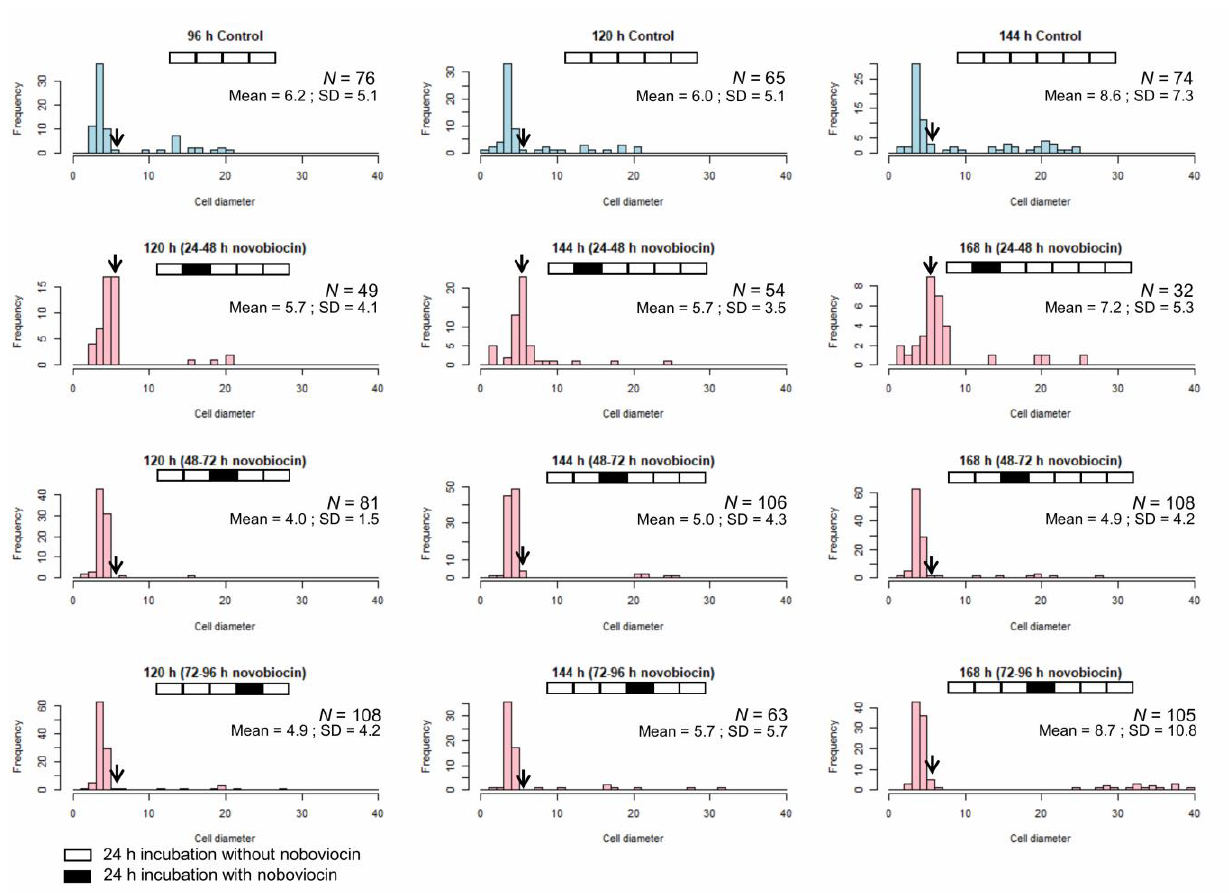
FIGURE 3: Size distribution of the control E. faecalis protoplast cells and E. faecalis protoplast cells treated with novobiocin for 24 h. Ar- rows indicate the fraction of cells with a diameter between 5 a nd 6 μm.